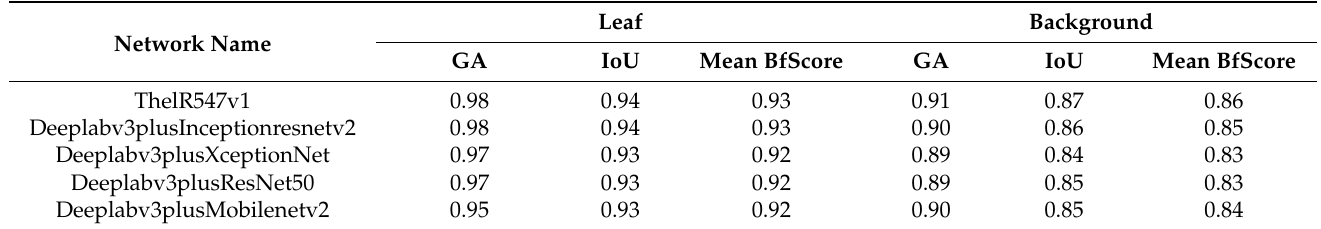
Table 7. Network overall performance for each individual class prediction (leaf and background).